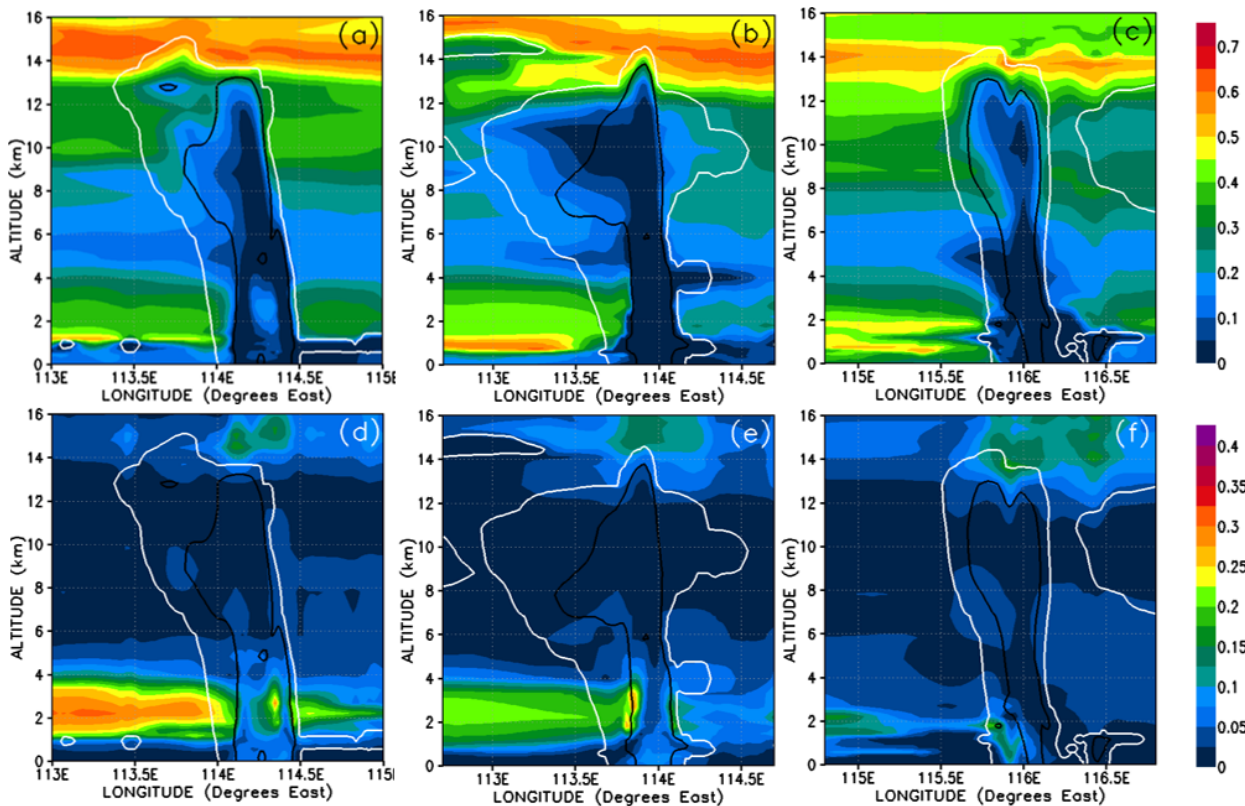
Figure 13. Vertical cross sections of mixing ratios (expressed in Br pptv) of HBr (a–c) and HOBr (d–f) bromine compounds. The left, middle, and right columns correspond to cross sections of Mod_Conv_4.35N at 4.35 ◦ N at 06:00UTC, Mod_Conv_3.75N at 3.75 ◦ N at 09:00UTC, and Mod_Conv_5.4N at 5.4 ◦ N at